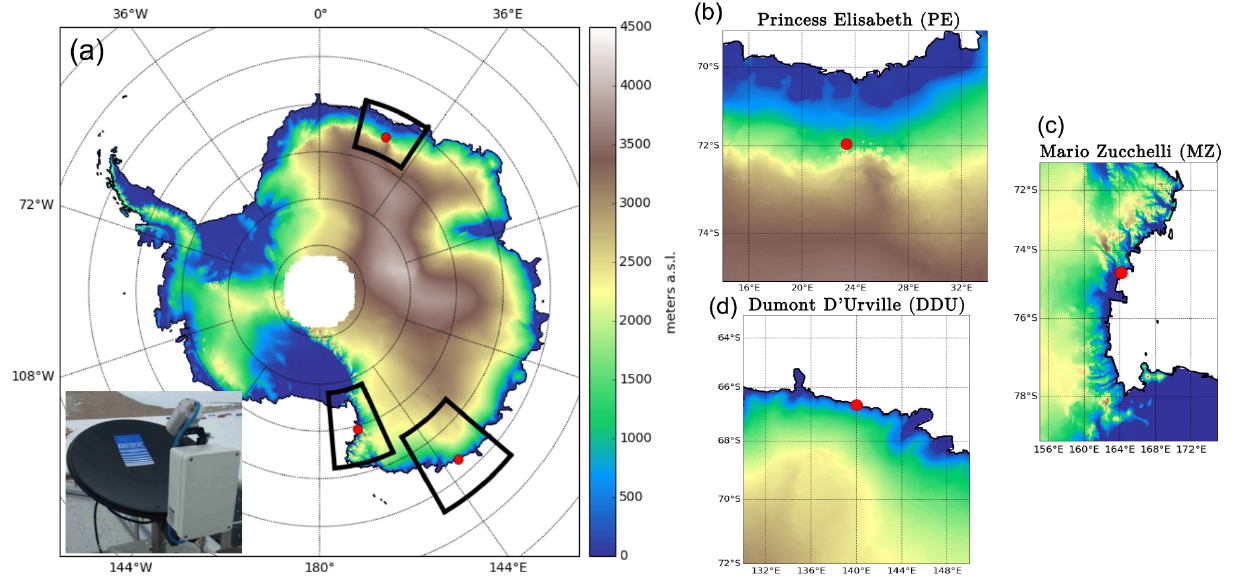
Figure 1. (a) Digital elevation map of the Antarctic Ice Sheet (Liu et al., 2015) with three insets corresponding to the location of the Micro Rain Radars: (b) Princess Elisabeth station (PE), (c) Mario Zucchelli station (MZ) and (d) Dumont D’Urville station (DDU). The inset at the bottom left shows the Micro Rain Radar at the Princess Elisabeth